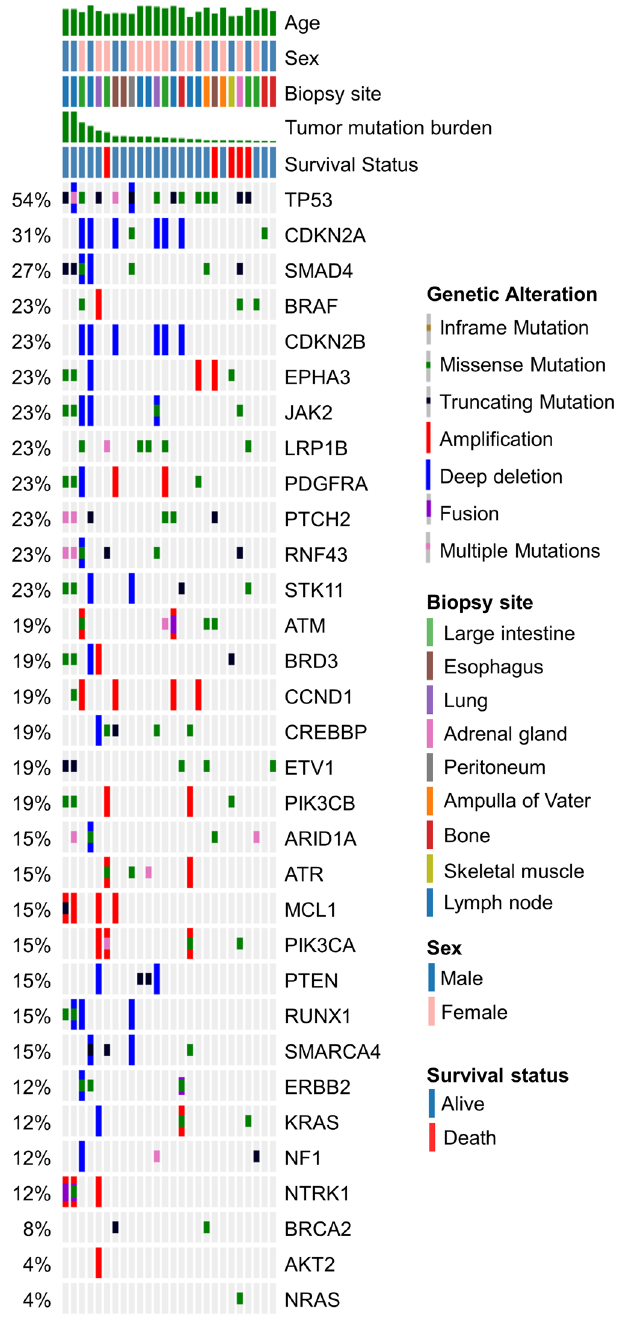
Figure 1. Genetic alterations in patients with